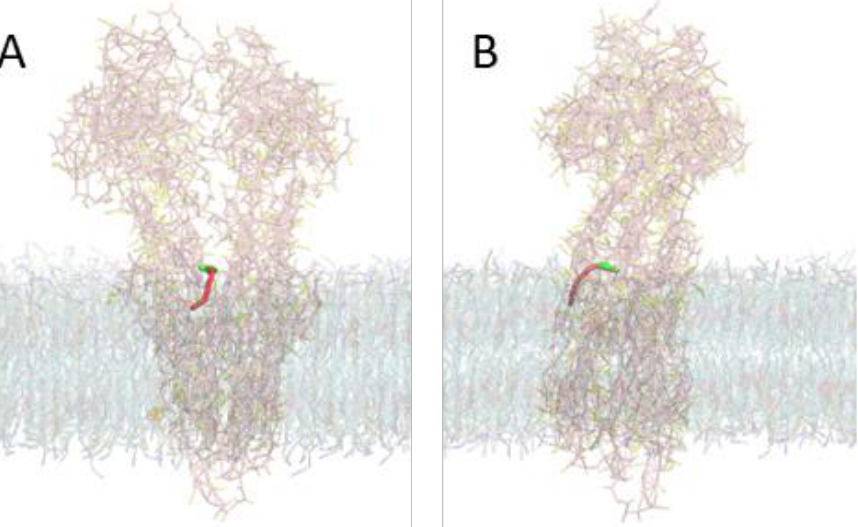
Figure 12. Snapshot of NBD–C16 with the NBD COM restricted at d = 0.5 nm from P–gp’s TM COM, obtained at the end of the 200 ns MD simulation. In plot ( A ), the P–gp’s gate between TM4/6 is facing to front, and, in plot ( B ), it is facing to the left side.